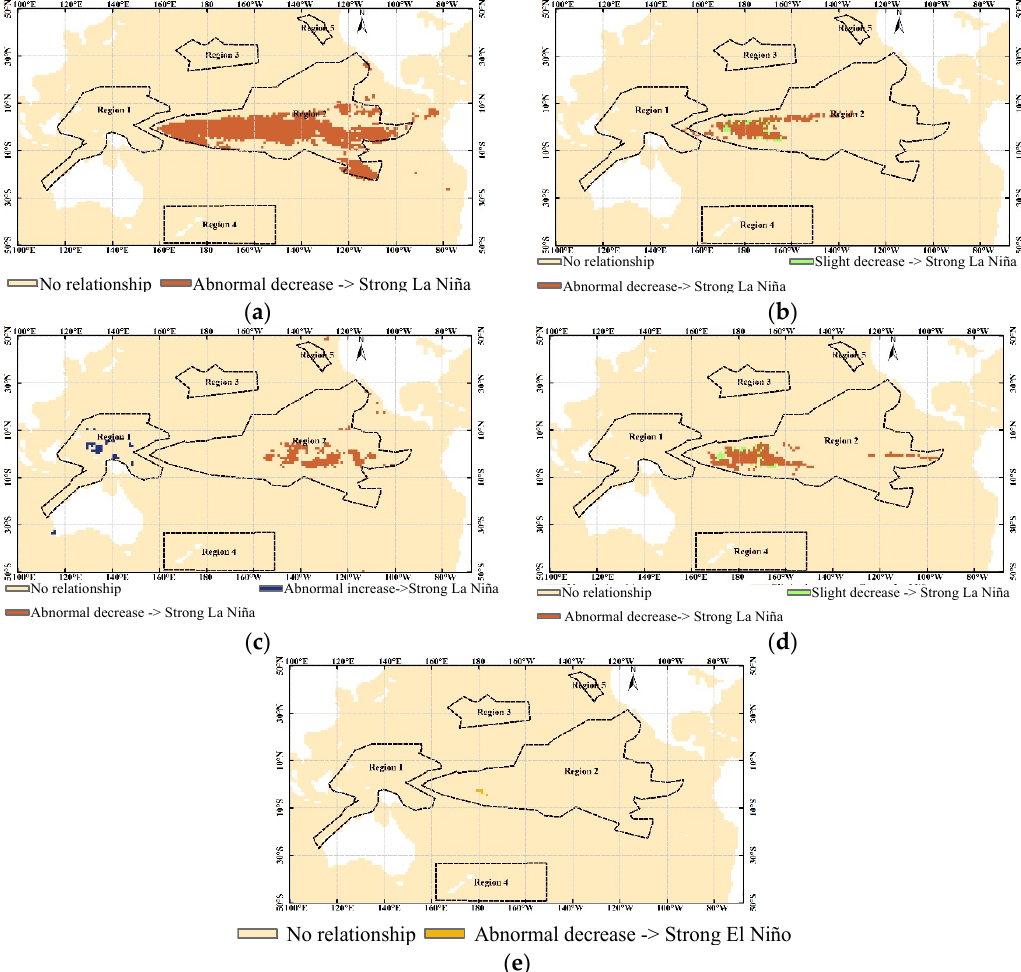
Figure 3. Variations in marine environment causing ENSO events in PO. ( a ) Association pattern from SSTA to ENSO; ( b ) Association pattern from SSPA to ENSO; ( c ) Association pattern from SLAA to ENSO; ( d ) Association pattern from WSA to ENSO; ( e ) Association pattern from CHLA to ENSO.